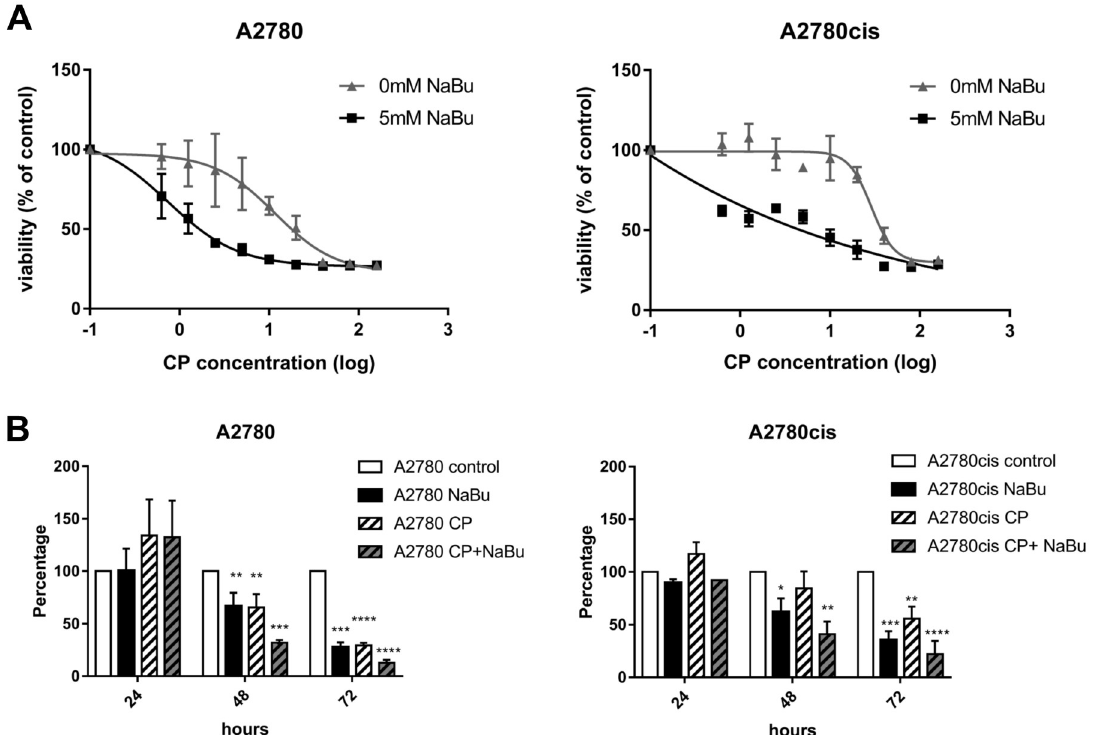
Fig 1. Sodium butyrate enhances the cytotoxic effect of cisplatin. Cell proliferation/viability was measured using colorimetric WST-1 assay. Data are presented as the percentage relative to untreated cells, arbitrary set to 100%. Dose response of A2780 and A2780cis cells to 48 h treatment with CP alone or in combination with NaBu (5 mM) (A). Each point represents the mean ± SD from 2 independent experiments. Dynamic of antiproliferative effect of NaBu (5 mM) alone and in combination with CP (5 μ M) (B). The data points in the graph are the means ± SD of 3 independent experiments. Significance was tested using one-way ANOVA. � P � 0.05, �� P � 0.01, ��� P � 0.001, ���� P � 0.0001 are significantly different from control